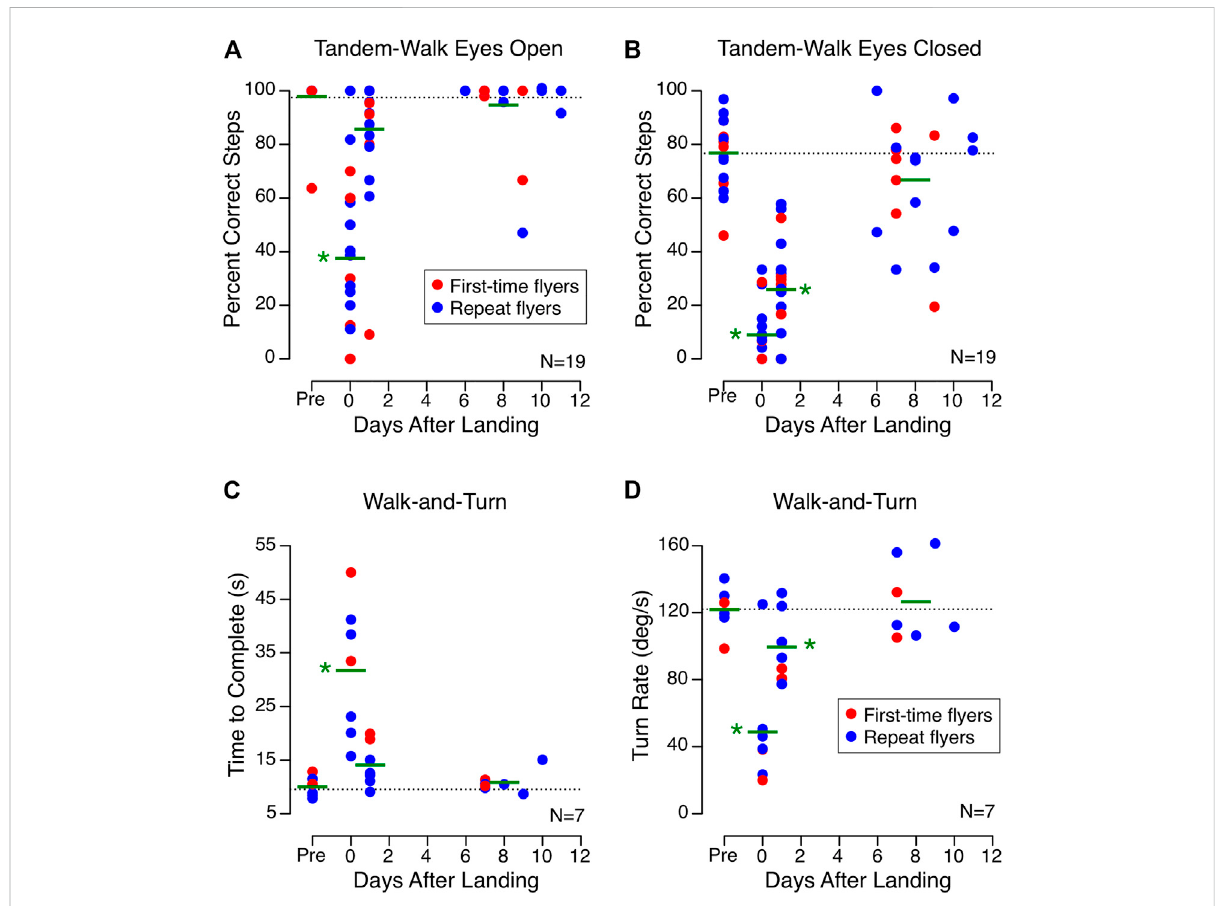
FIGURE 4 Locomotion tasks. Percent of correct steps during the tandem-walk test with eyes open (A) and with eyes closed (B) for 19 astronauts before (Pre)andafterspace fl ight.Timetocompletetheobstaclecourse (C) andturnratearoundthecone (D) duringthewalk-and-turntaskfor7astronauts before (Pre) and after space fl ight. Each symbol represents the data from an individual subject and the horizontal blue lines represent the subjects mean for each major time point. The dotted line represents the mean of all pre fl ight measures. * p < 0.05 relative to pre fl ight values.